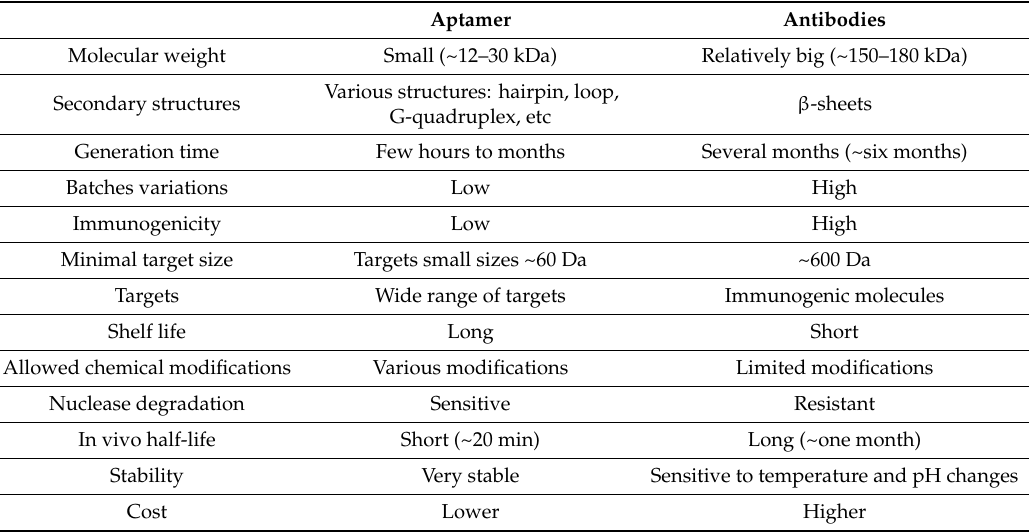
Table 2. Comparison between aptamers and